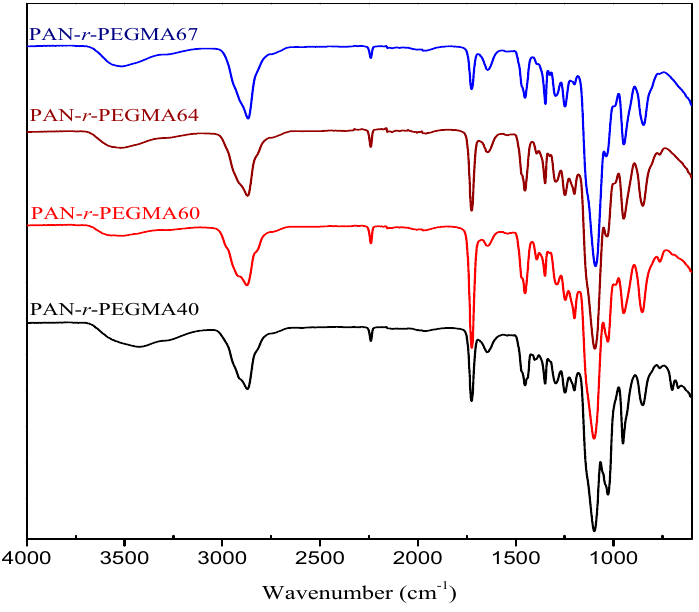
Figure 1. FTIR spectra for PAN- r -PEGMA copolymers.